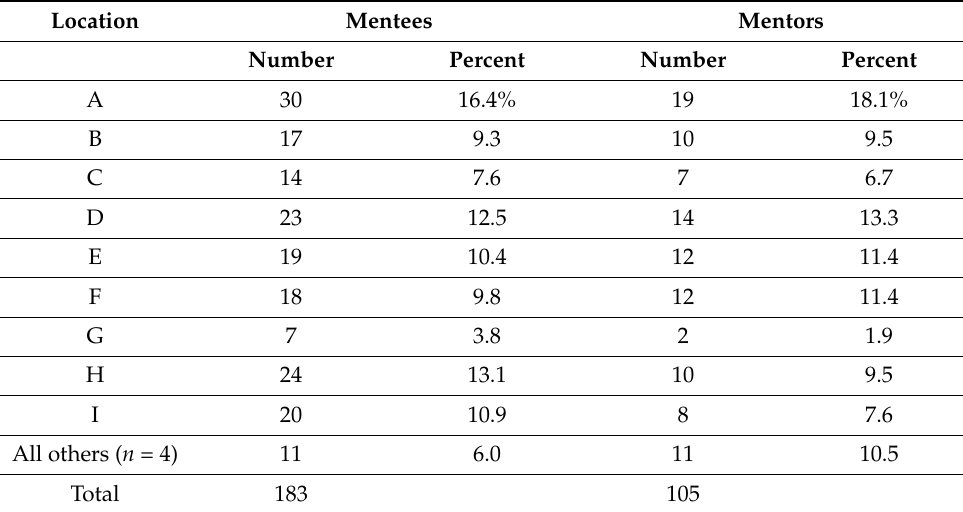
Table 1. Number and percent of mentees by location, and mentors who